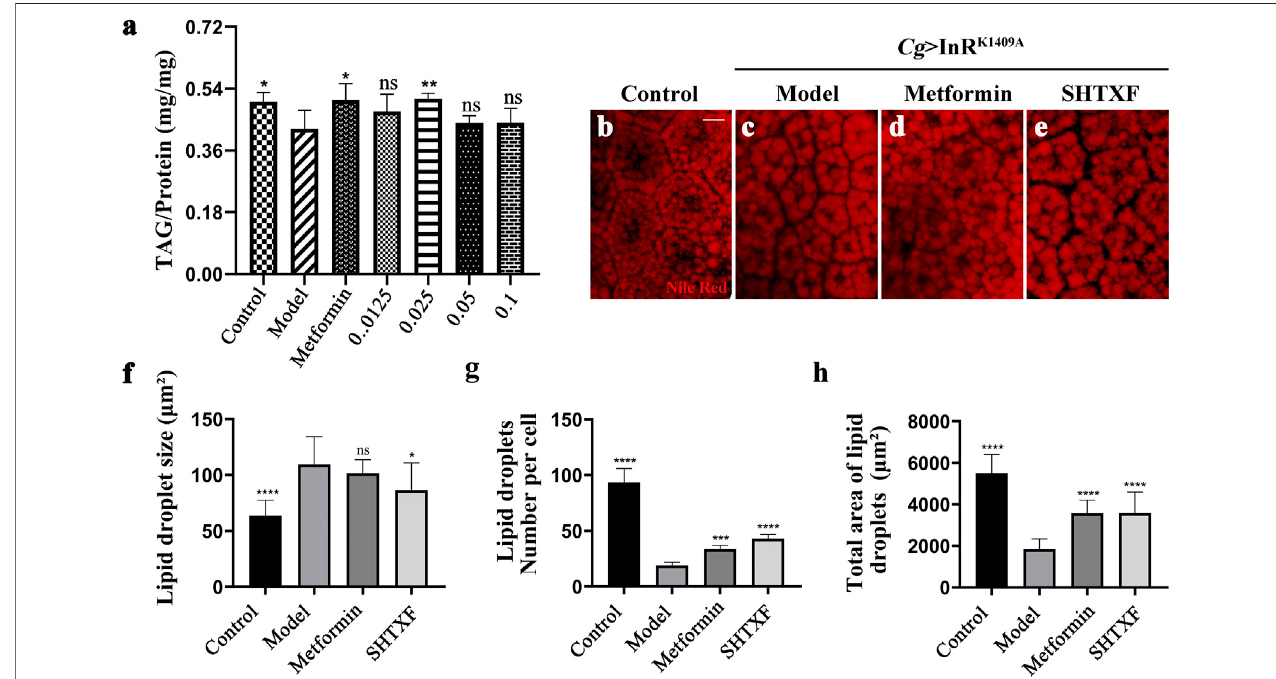
FIGURE 4 | SHTXF rescues the IR-induced lipid homeostasis disorder. (A) Assays for stored triglycerides (TAG) contents of Drosophila larval stage, which are presented relative to the protein contents of the tissue sample to normalize the weight difference between control and other indicated groups (3 larvae per pool, n = 5). (B – E) Nileredstainingoflipidstoragedropletsinthelarvalfatbodyadiposetissue. (F – H) Quanti fi cationoflipiddropletsize (F) ,lipiddropletsnumber (G) ,andtotalareaof lipid droplets in Cg -Gal4/+ (control) larvae and Cg > InR K1409A larvae in normal, metformin-, or SHTXF-added diets ( n = 10). The error bars indicate the